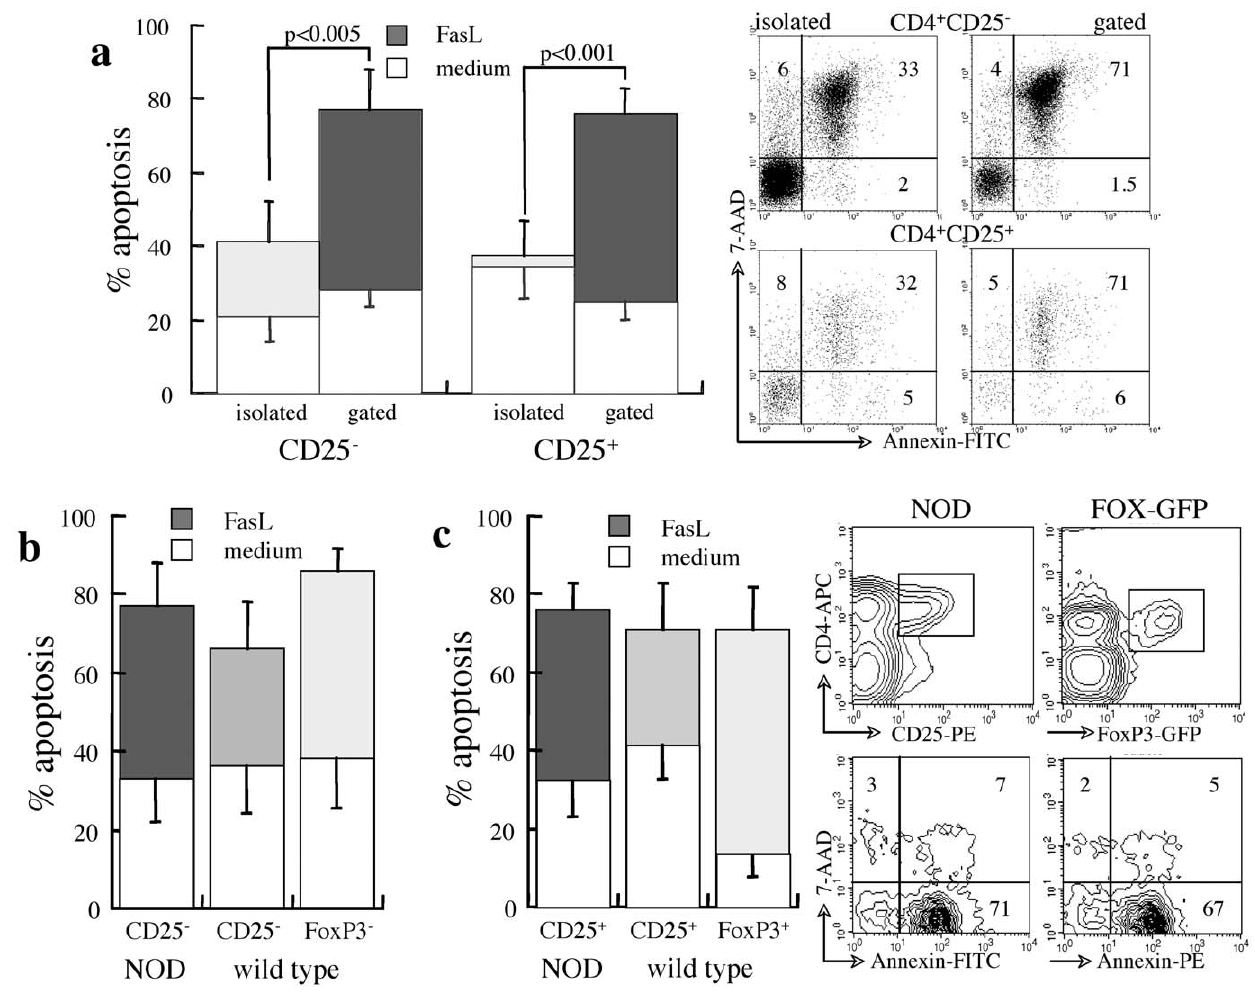
Figure 1. Sensitivity of naı¨ve/effector CD4 + T to Fas-mediated apoptosis. A. Apoptosis of splenocytes from prediabetic NOD females (14 weeks) during 48 hours of incubation in control medium and induced by 50 m g/ml FasL. Isolated CD4 + CD25 2 and CD4 + CD25 + T cell subsets (n=5) are compared to measurements performed by gating in mixed splenocyte cultures (n=7). Representative measurements of apoptosis and death assessed by incorporation of Annexin-V and 7-AAD respectively, in isolated and gated CD4 + T cell subsets. B–C. Apoptosis of gated naı¨ve/effector CD25 2 and FoxP3 2 subsets (B) and CD25 + and FoxP3 + Treg (C) in mixed cultures of splenocytes from prediabetic NOD females (n=5), wild type mice (C57/BL, n=7) and Foxp3-GFP transgenes (n=5) during 48 hours of incubation in control medium and with 50 m g/ml FasL. The plots of present apoptosis in gated CD4 + CD25 + and CD4 + FoxP3-GFP + cells.